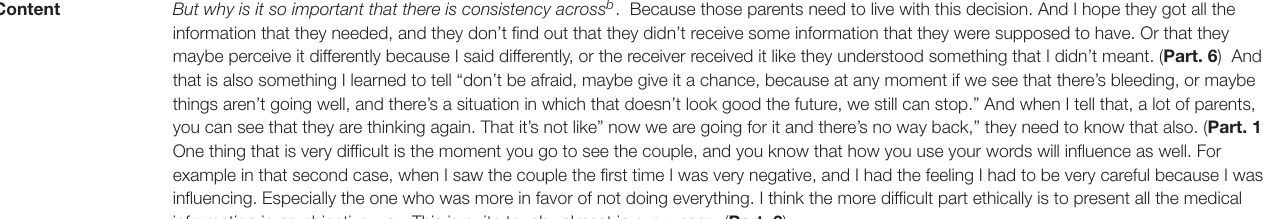
TABLE 3 | Illustrative quotes: clinical-ethical decision-making and counseling a . Content